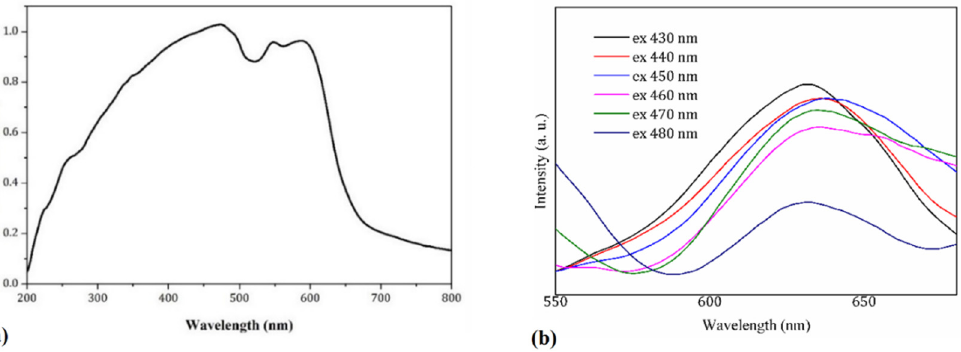
Figure 3. ( a ) UV–Vis spectrum and ( b ) fluorescence spectra of [Zn 3 (valhydr) 2 (RhB) 2 (EtOH) 2 ](ClO 4 ) 2 in solid state.